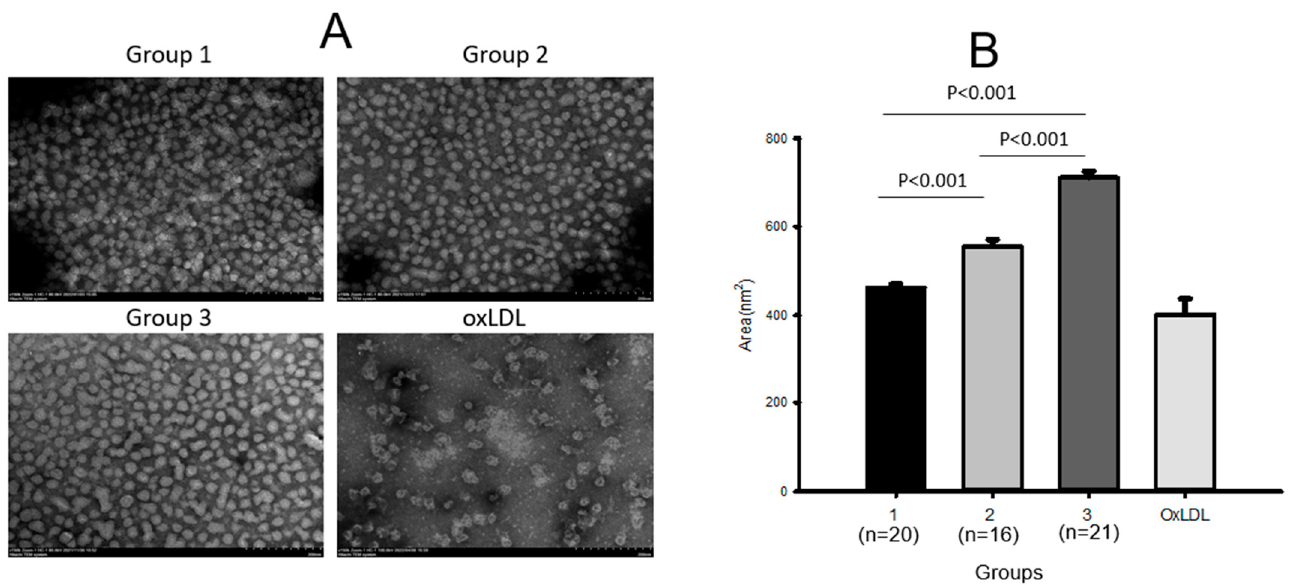
Figure 1. Transmission electron microscopy (TEM) images ( A ) and area analysis ( B ) of LDL from each